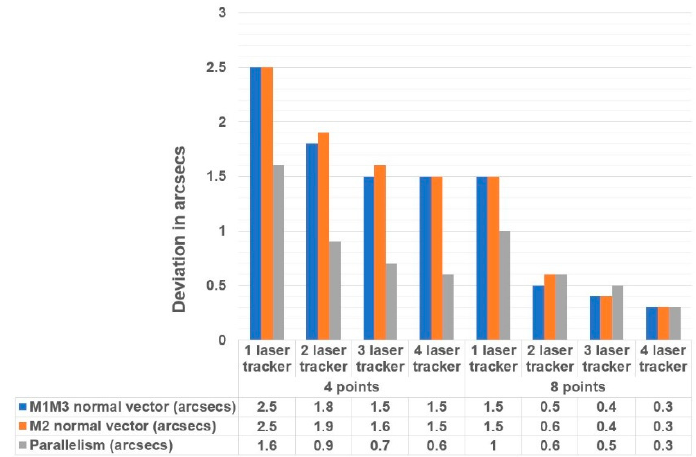
Figure 14. Measurement uncertainty of the normal vector of the M1M3 and M2 mirrors.